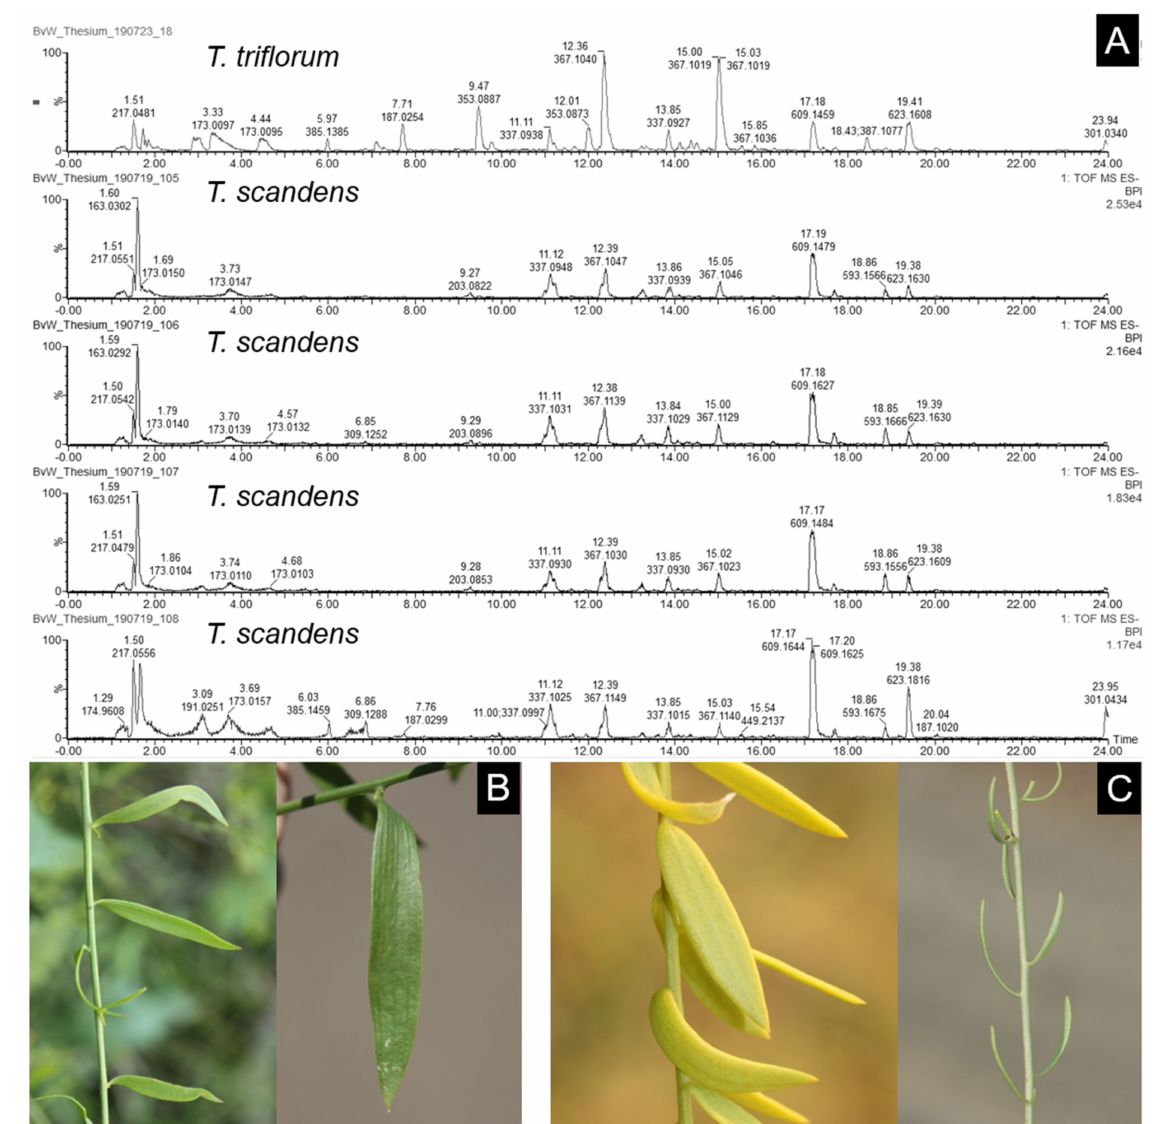
Figure 6. Comparison of the phenolic compound composition and morphology between two closely related Thesium species, T. triflorum and T. scandens . ( A ). Total ion chromatograms of a T. triflorum plant from near St. Lucia, KwaZulu-Natal, South Africa ( top ) and four T. scandens plants from Eastern Cape, South Africa ( bottom ). ( B ). Flat linear to linear-lanceolate leaves of T. triflorum with one to three (five) main veins. ( C ). Fleshy and often terete leaves of T. scandens lacking clearly visible